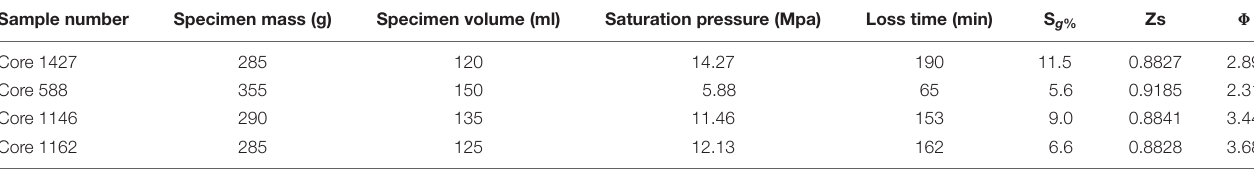
TABLE 3 | Sample parameters.